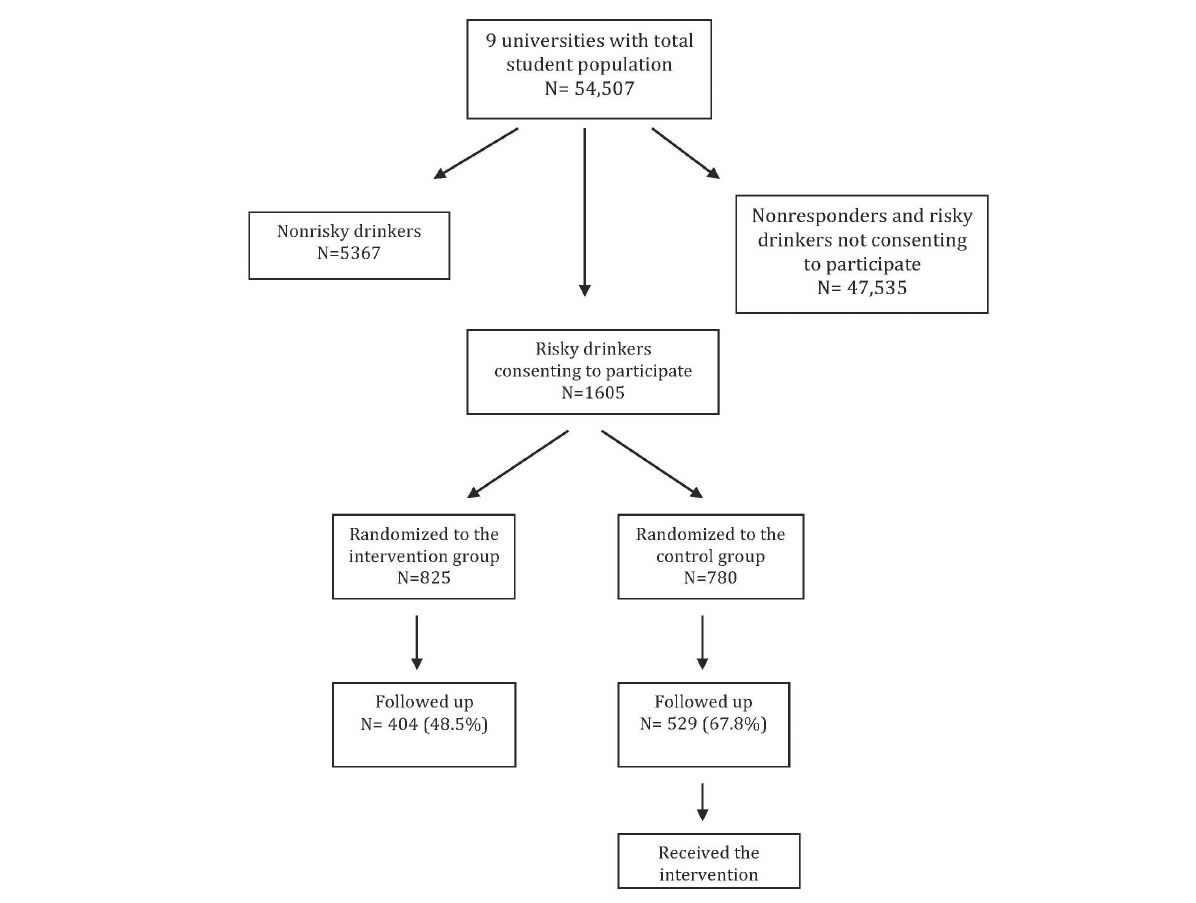
Figure 4. Flowchart of the AMADEUS